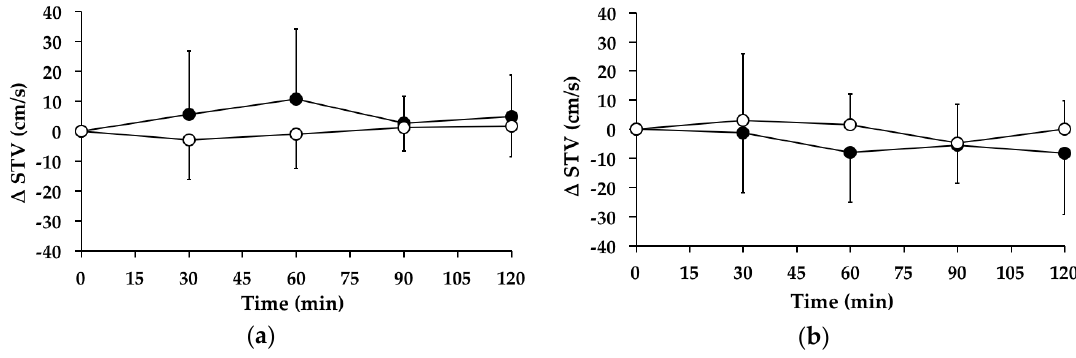
Figure 6. Mean change ( (cid:52) ) in swing time variability (STV) on “WW” ( ) and “GW” ( ) days in subjects: ( a ) with postprandial hypotension (PPH); and ( b ) without PPH. Data are mean ± standard deviation (SD) represented by vertical bars.